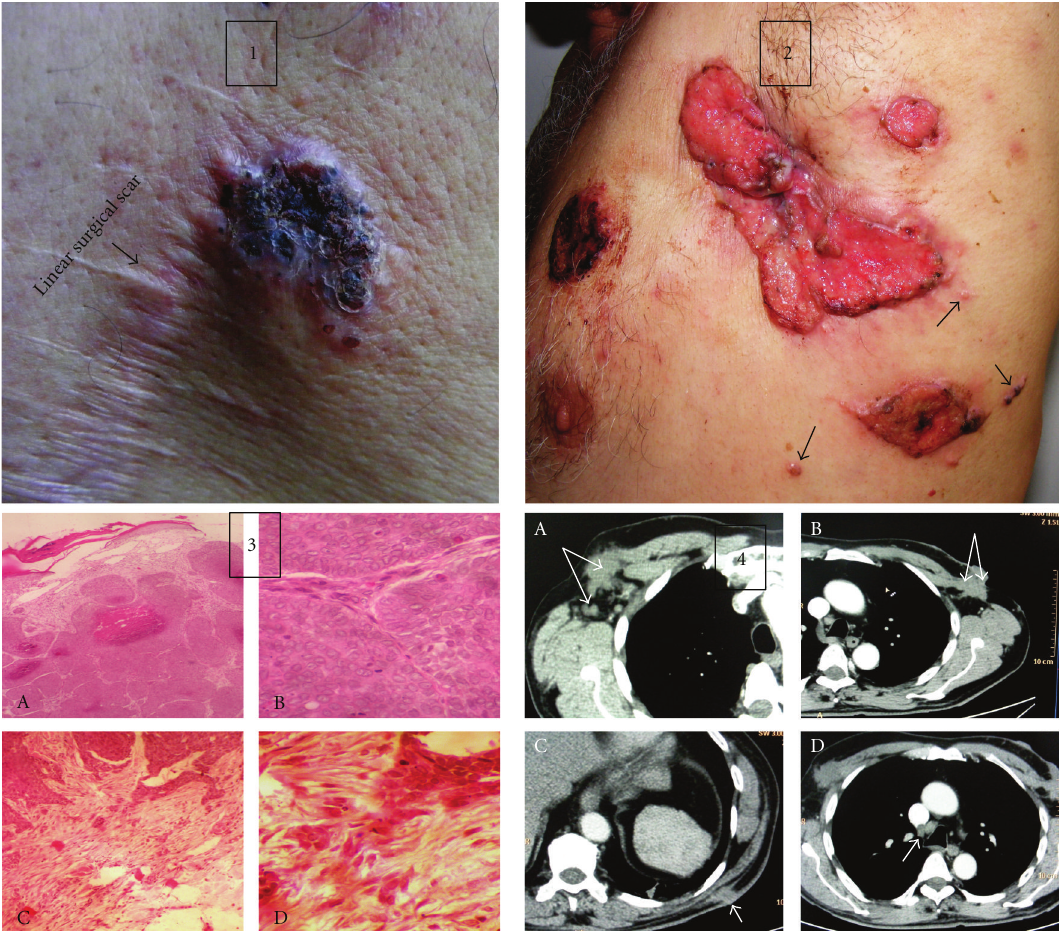
Figure 1: Panel 1: a nodulo-ulcerative basal cell carcinoma (BCC) plaque having characteristic indurated margins and pigmented crusts in the centre over back. Note the BCC lesion involving the margin of old linear scar. Panel 2: a large irregular nodulo-ulcerative fleshy plaque in left axilla. Puckering suggests adherence to other structures. Note typical beaded and pigmented borders and 3 morphologically similar lesions in its vicinity. Also note small satellite papulonodules indicative of local spread (arrow heads). Panel 3 (histology (A)): epidermis shows focal epidermal ulceration while dermis has numerous nests of basaloid cells (H and E, × 10). (B) The basaloid cells have increased mitotic activity and are arranged in peripheral palisading pattern with areas of central necrosis (H and E, × 40). (C and D) Tumor infiltrating the deeper layers is suggestive of infiltrative BCC (H and E, × 10 and × 40). Panel 4: CT scan (arrows) shows homogenously enhancing tumor infiltrating the underlying lymph nodes and muscles in right axilla (A) and left axilla (B). A subcutaneous tumor along the posterior axillary line (C). Enlarged lymph nodes in pretracheal region